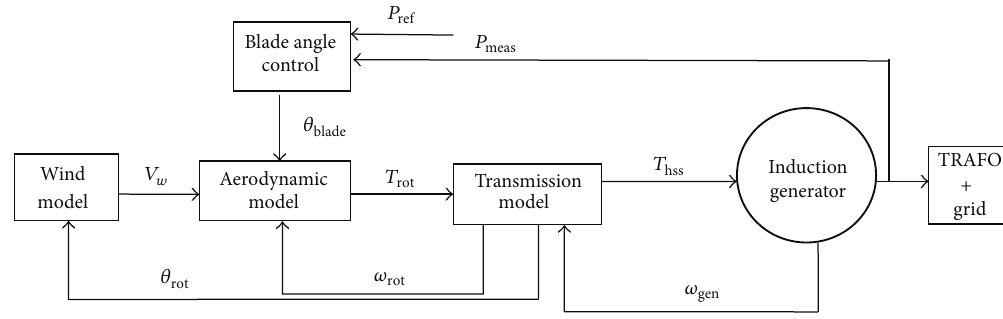
Figure 3: General block diagram of FSWES.